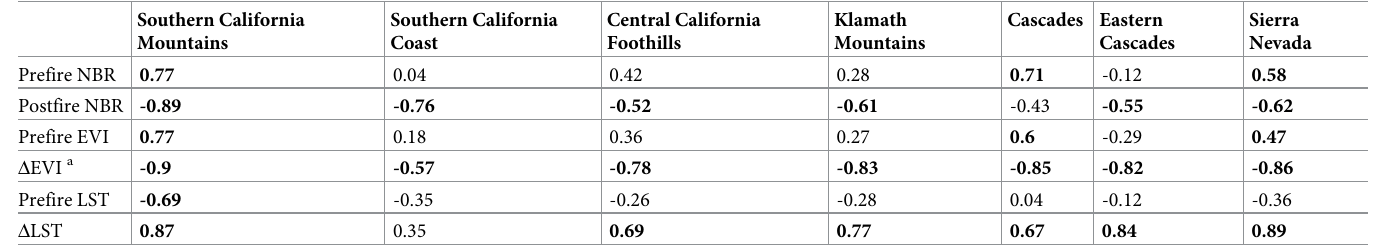
Table 4. Pearson temporal correlations (r values) between average early-summer burn severity (RdNBR) and burned area averages of six biophysical variables within each of the seven ecoregions of California. Southern California